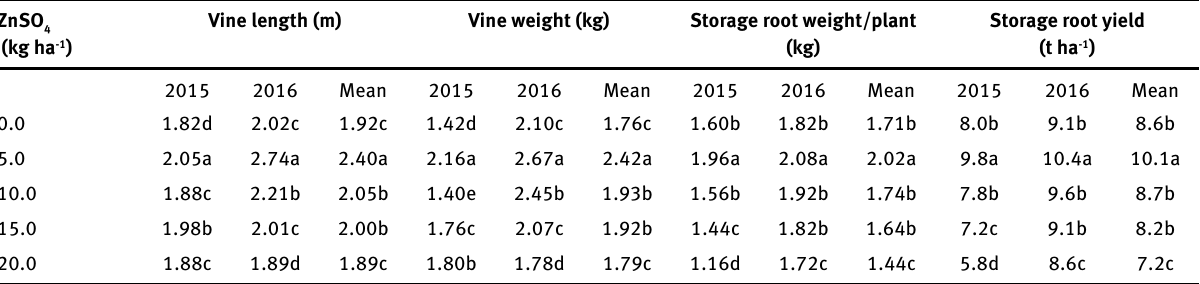
Figure 1: Yield response of sweet potato to applied Zn fertilizer on the foliage and storage root yield parameters of sweet potato Table 3: Effect of ZnSO 4 ZnSO 4 (kg ha -1 )